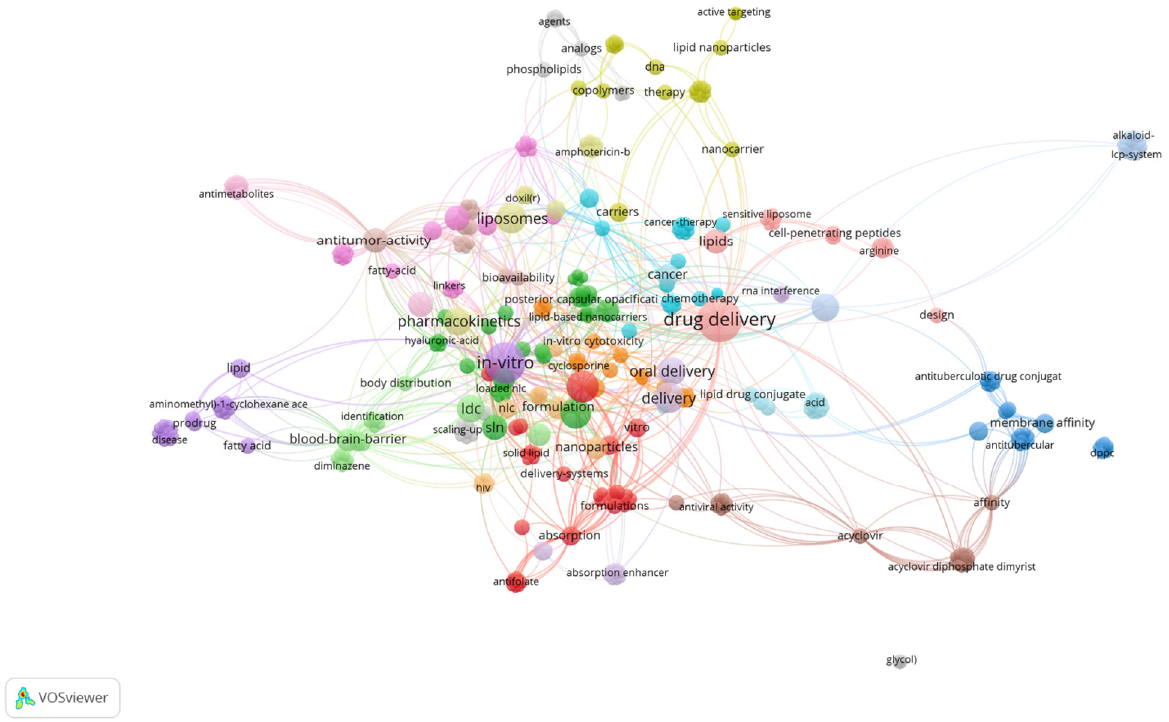
Figure 1. Bibliometric map obtained by VOSviewer software version 1.6.16 using “lipid drug con- jugates” as the only keyword, from Web of Science database [3] .